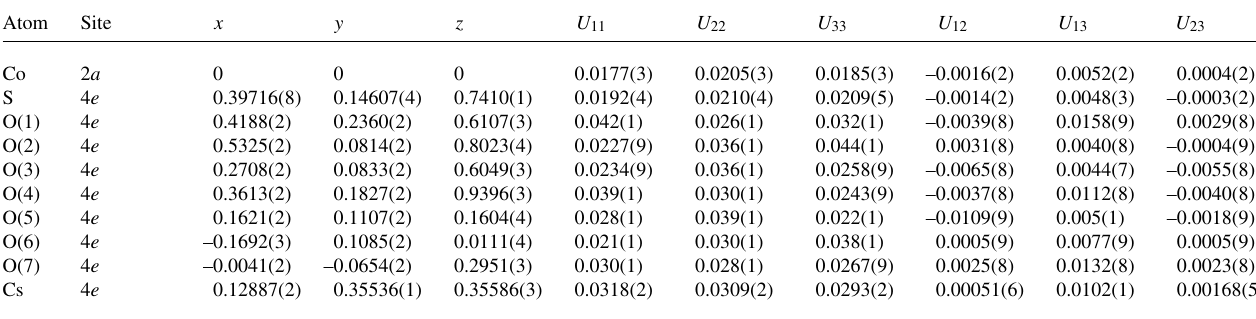
Table 12. Atomic coordinates and displacement parameters (in Å 2 )